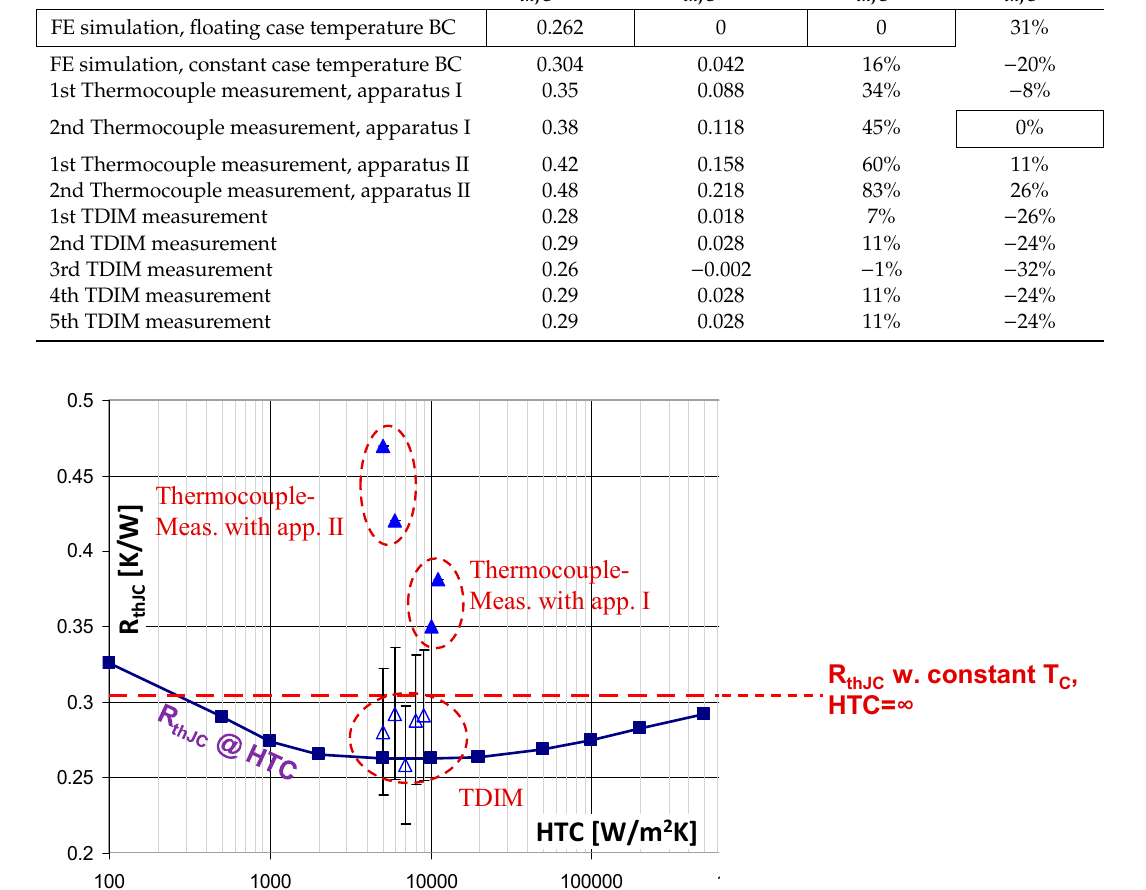
Table 3. Comparison of R thJC of a MOSFET device obtained using di ff erent methods. Method